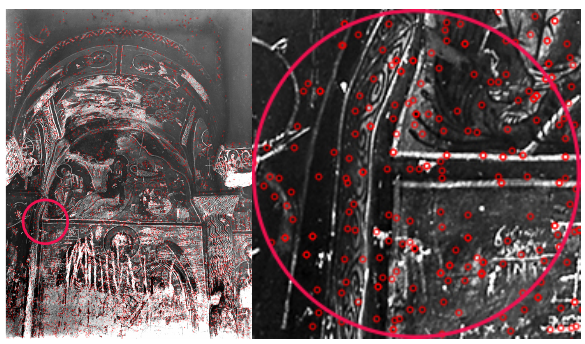
Figure 5. Keypoints automatically extracted from the software.